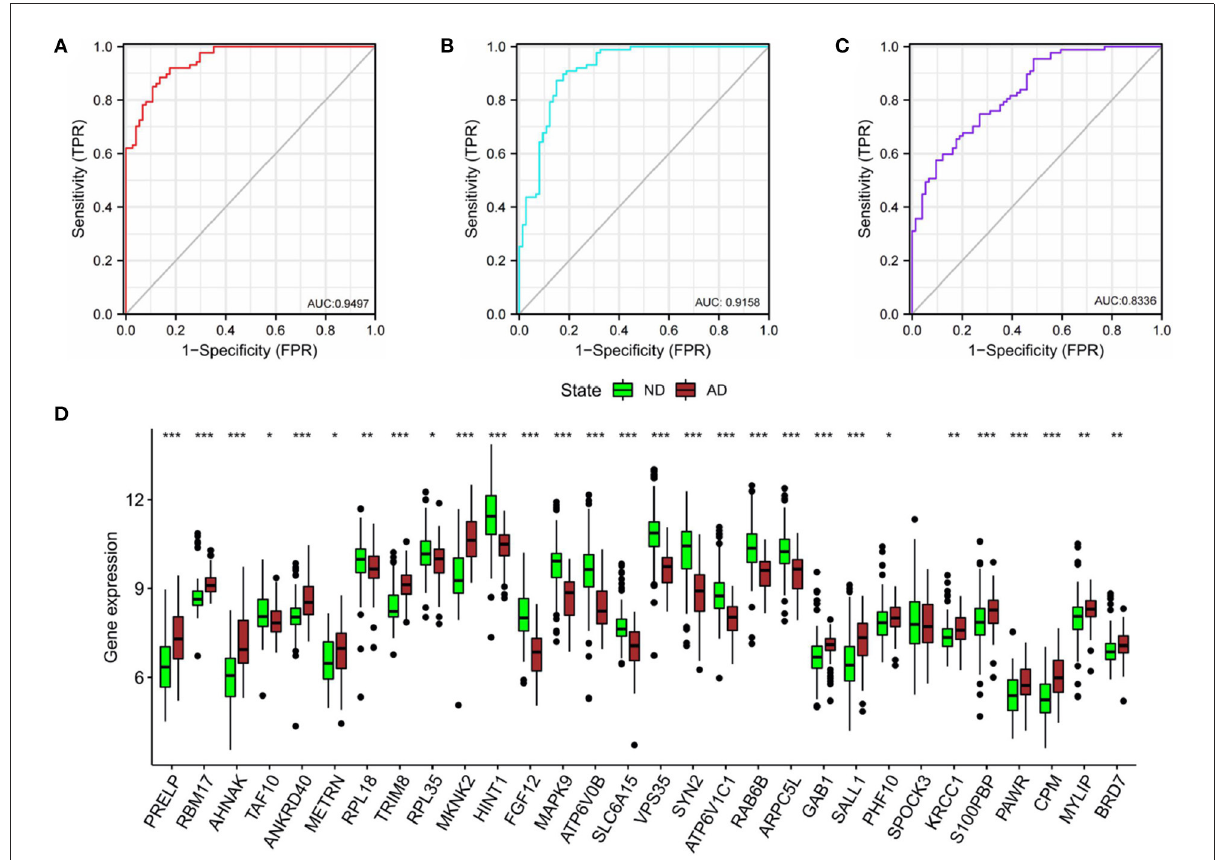
FIGURE11 Validation of diagnostic value. (A) The combined diagnostic value of eight genes in subgroup I. (B) The combined diagnostic value of eight genes in subgroup II. (C) The combined diagnostic value of eight genes in subgroup III. glm function to build logistics model, pROC package for ROC analysis. (D) Expression of hub genes in ND and AD groups. n = 74–87. vs. ND, Wilcoxon’s rank-sum test, * P < 0.05; ** P < 0.01; *** P <